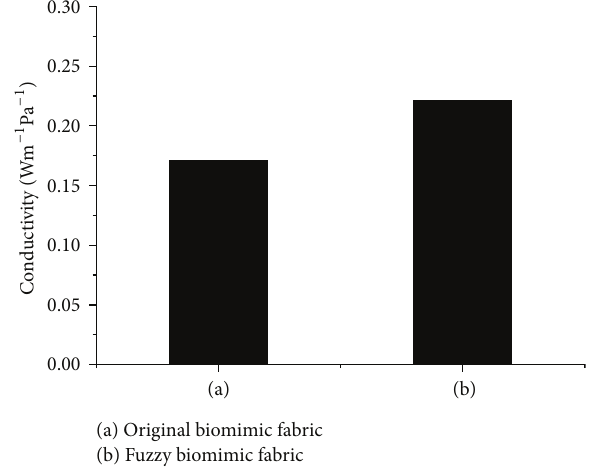
Figure 3: Moisture conductivity of biomimic woolen woven